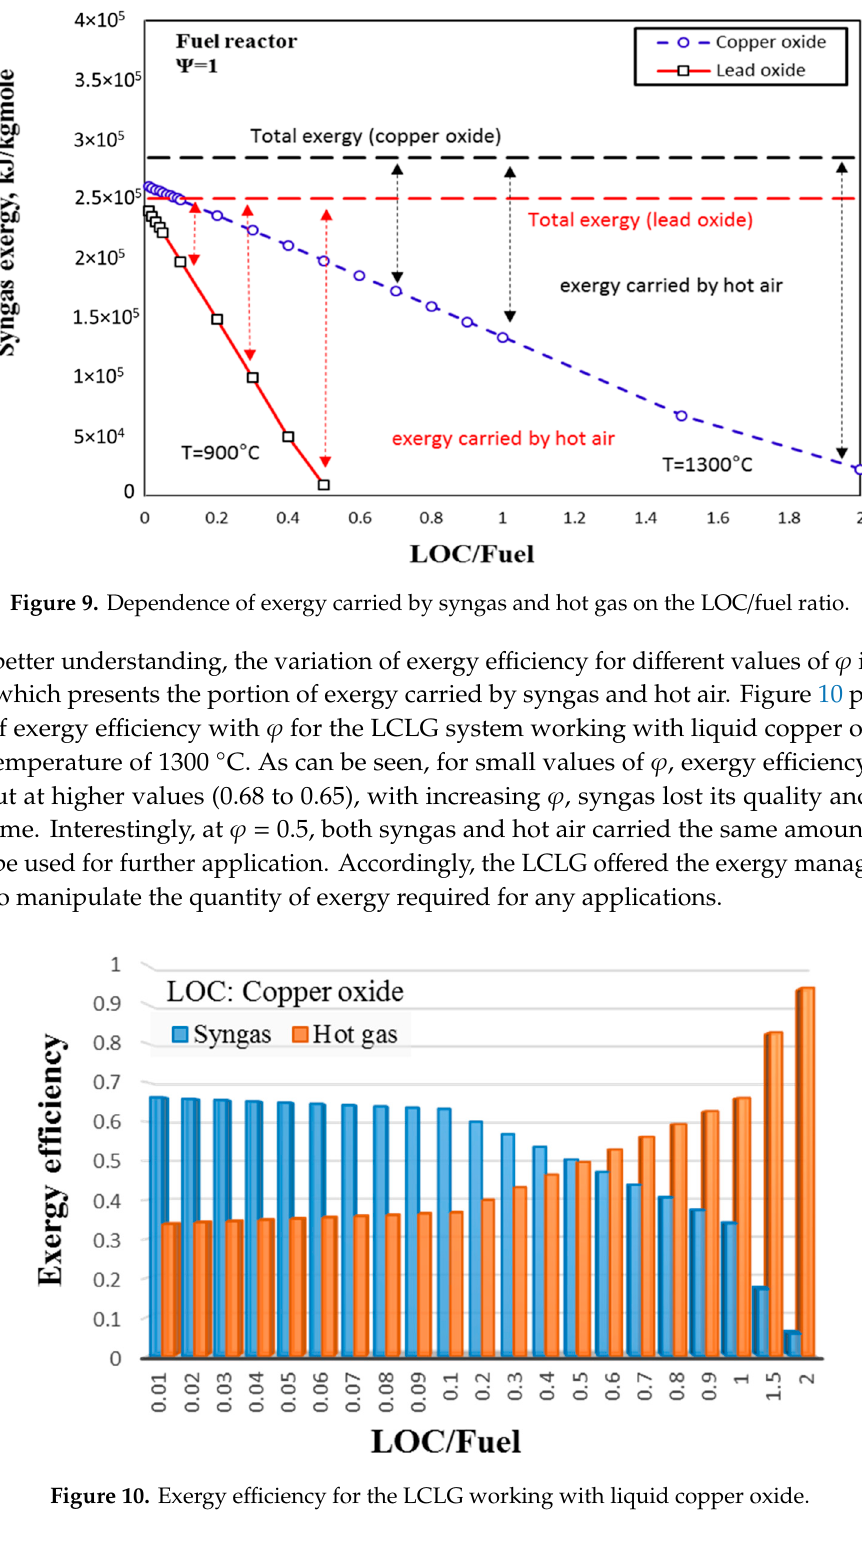
Figure 11. Exergy efficiency for LCLG working with liquid lead oxide. 3.4. Comparison of the Proposed Power Cycles and Those Available in the Literature To compare the energetic performance of the proposed power cycles with those available in the literature, power cycles working at similar temperatures and pressure to that of the LCLG were selected from the literature. Figure 12 comparatively shows the FLE of the IGCC power cycle in comparison with the literature. The temperature was 1300 °C and the copper oxide was used in the